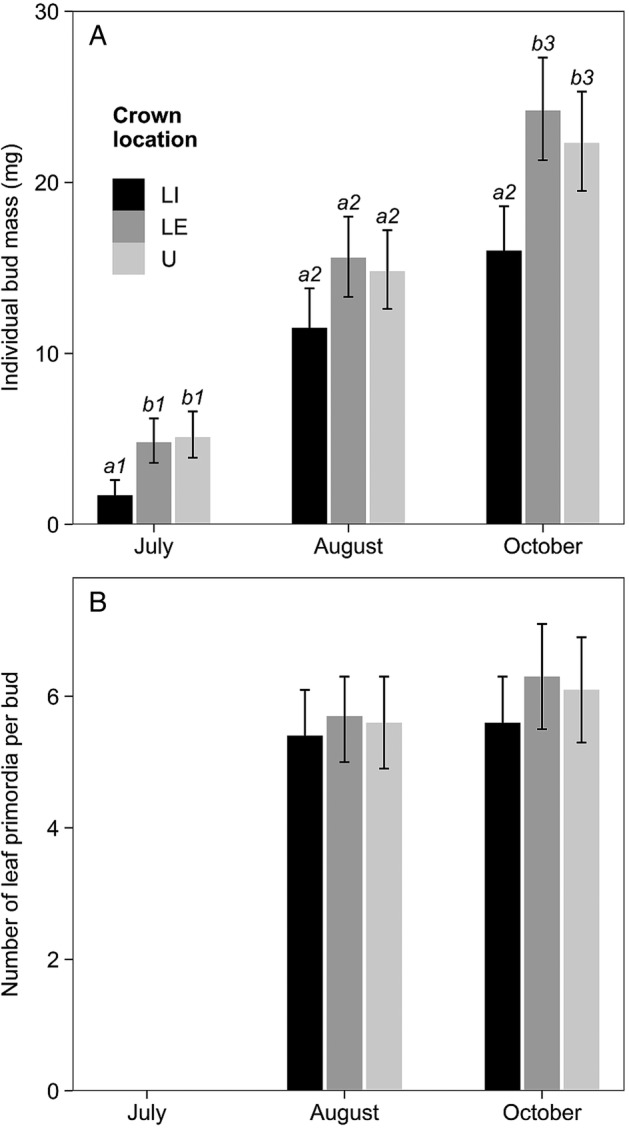
Mean individual bud mass (A) and mean number of leaf primordia per bud (B) in relation to crown location and sampling month. Error bars denote 95 % CI. Different letters indicate significant differences among crown locations (within each month), and different numbers indicate significant differences across sampling months (within each location). LI, lower-crown, interior-facing branches; LE, lower-crown, edge-facing branches; U, upper crown.